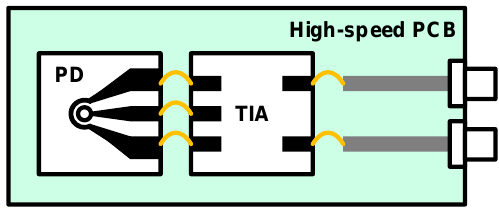
Figure 13. Illustration of wire-bonded EIC and PIC.